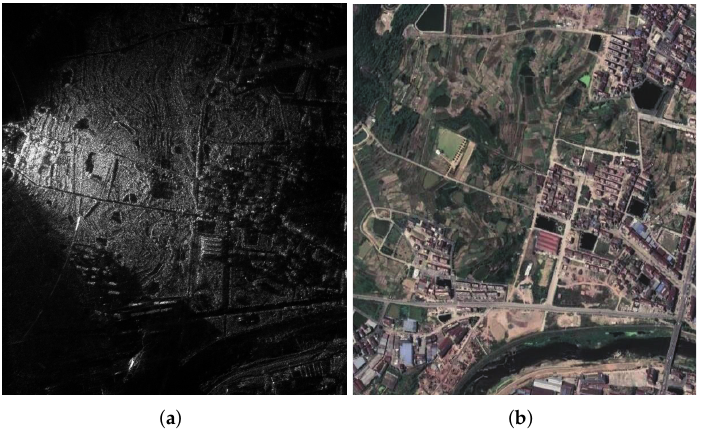
Figure 12. Imaging result and corresponding optical image of the equivalent experiment by the proposed method. The imaging swath width is 1.1 km × 1 km. ( a ) Imaging result of the equivalent experiment. ( b ) Optical image of the